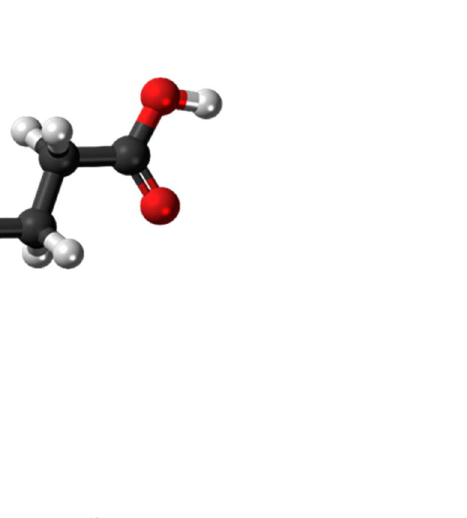
Figure 1. Schematic demonstration of Oxaprozin 10